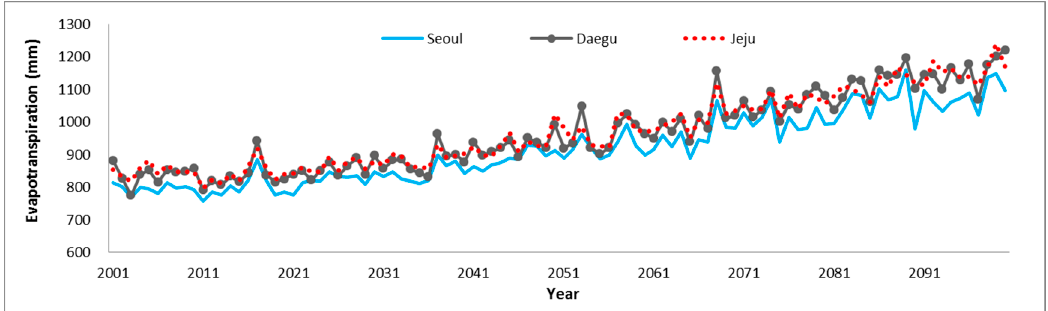
Figure 3. Result of evapotranspiration calculated with the RCP 8.5 scenario.